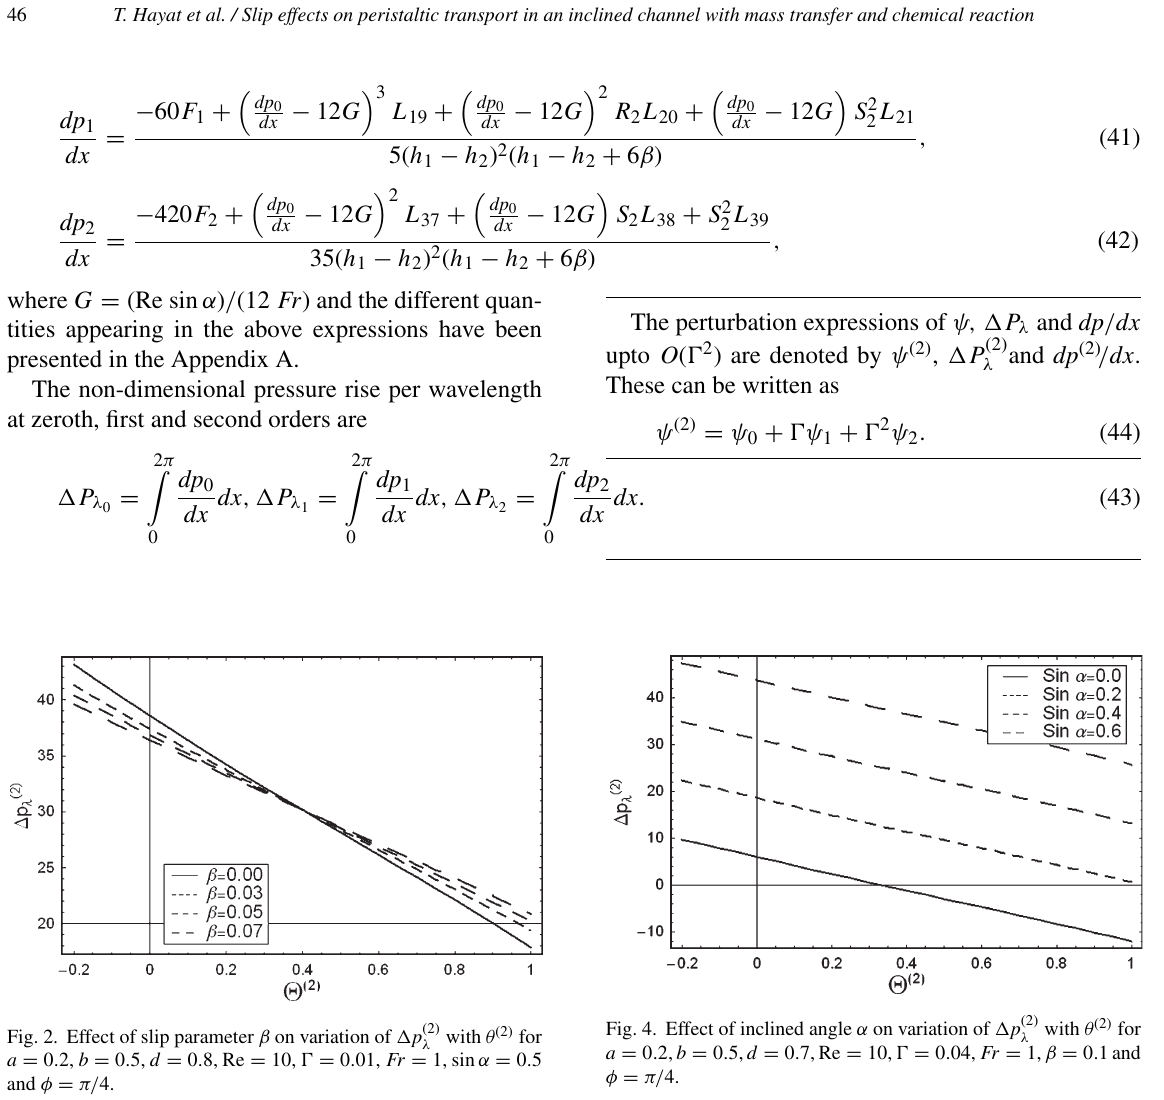
Fig. 2. Effect of slip parameter β on variation of (cid:16)p (2) a = 0 . 2, b = 0 . 5, d = 0 . 8, Re = 10, (cid:15) = 0 . 01, Fr = 1, sin α = 0 . 5 and φ = π/ 4.